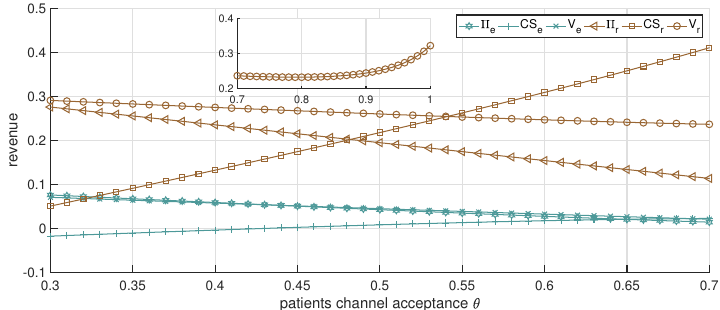
Figure 10. The impact of changes in θ on CS and V (dual-channel strategy p 0 =